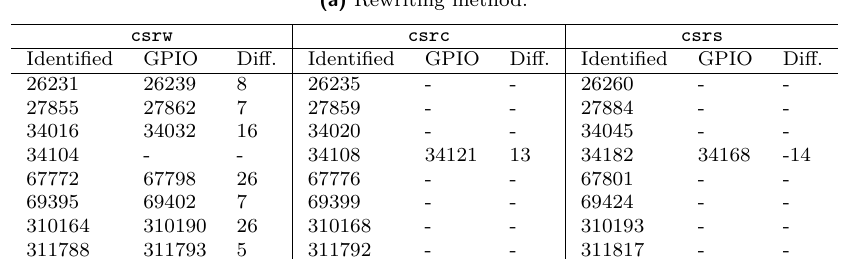
Table 10: Comparison of identified clock